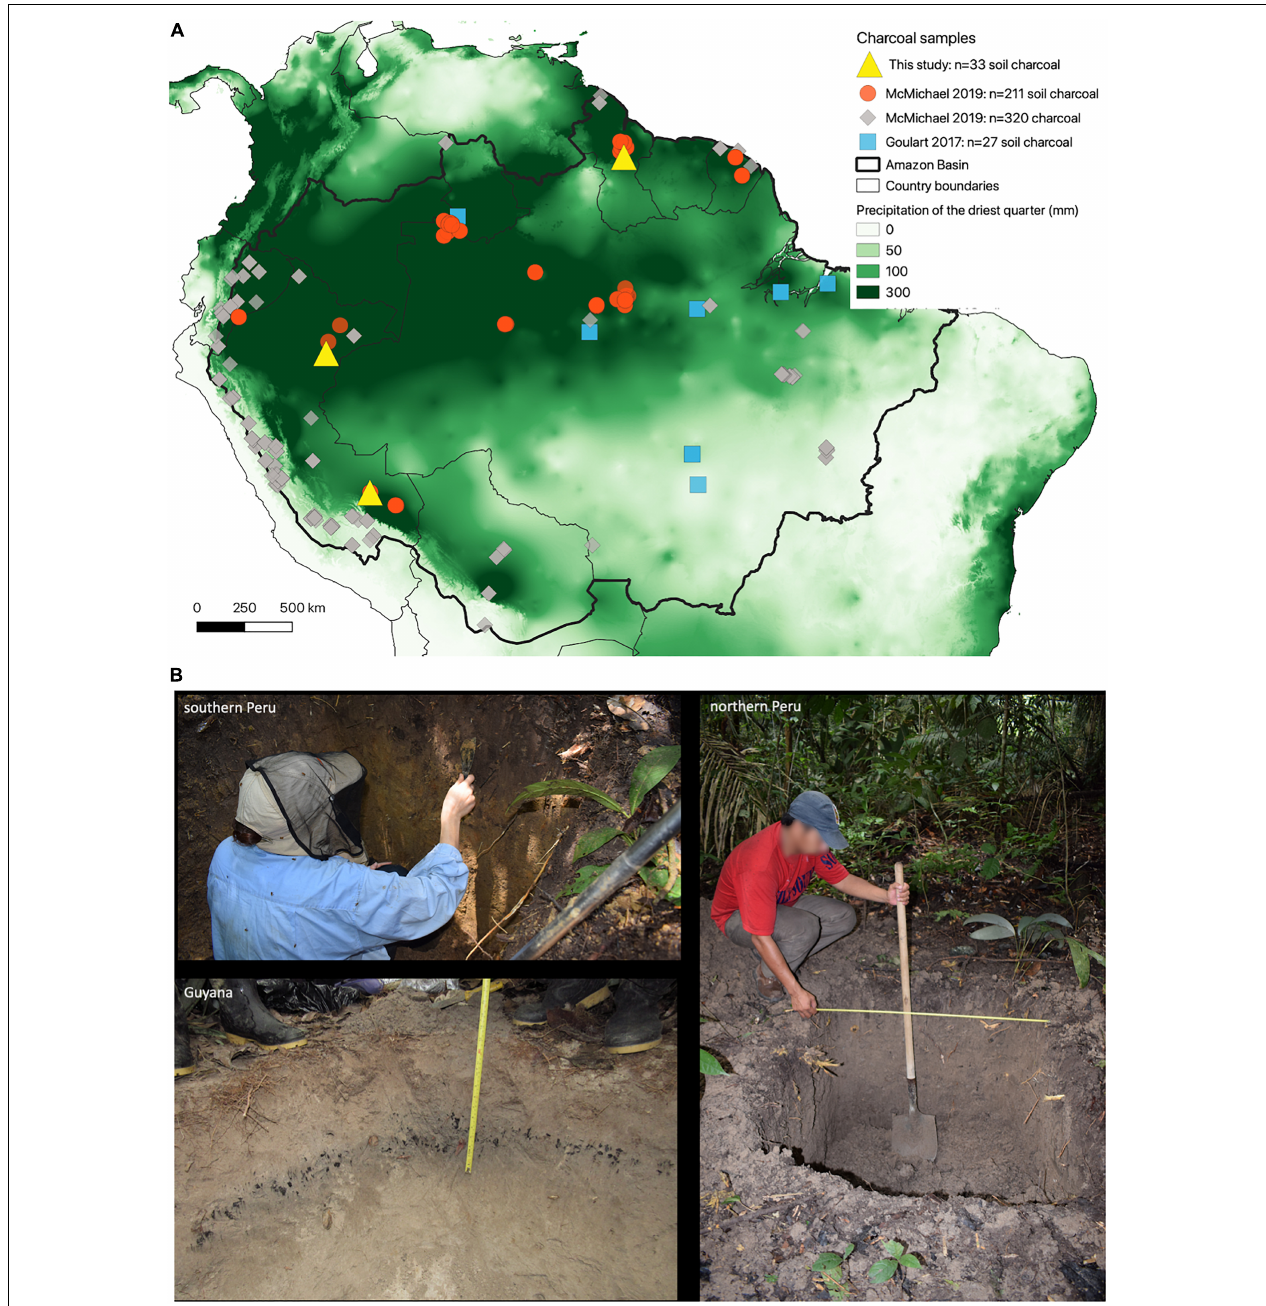
FIGURE 1 | (A) Map showing locations of charcoal samples in Amazonia, and (B) charcoal sampling from terra firme soil pits in southern Peru, northern Peru, and Guyana (clockwise from top left; photo credit: L. Carvalho).